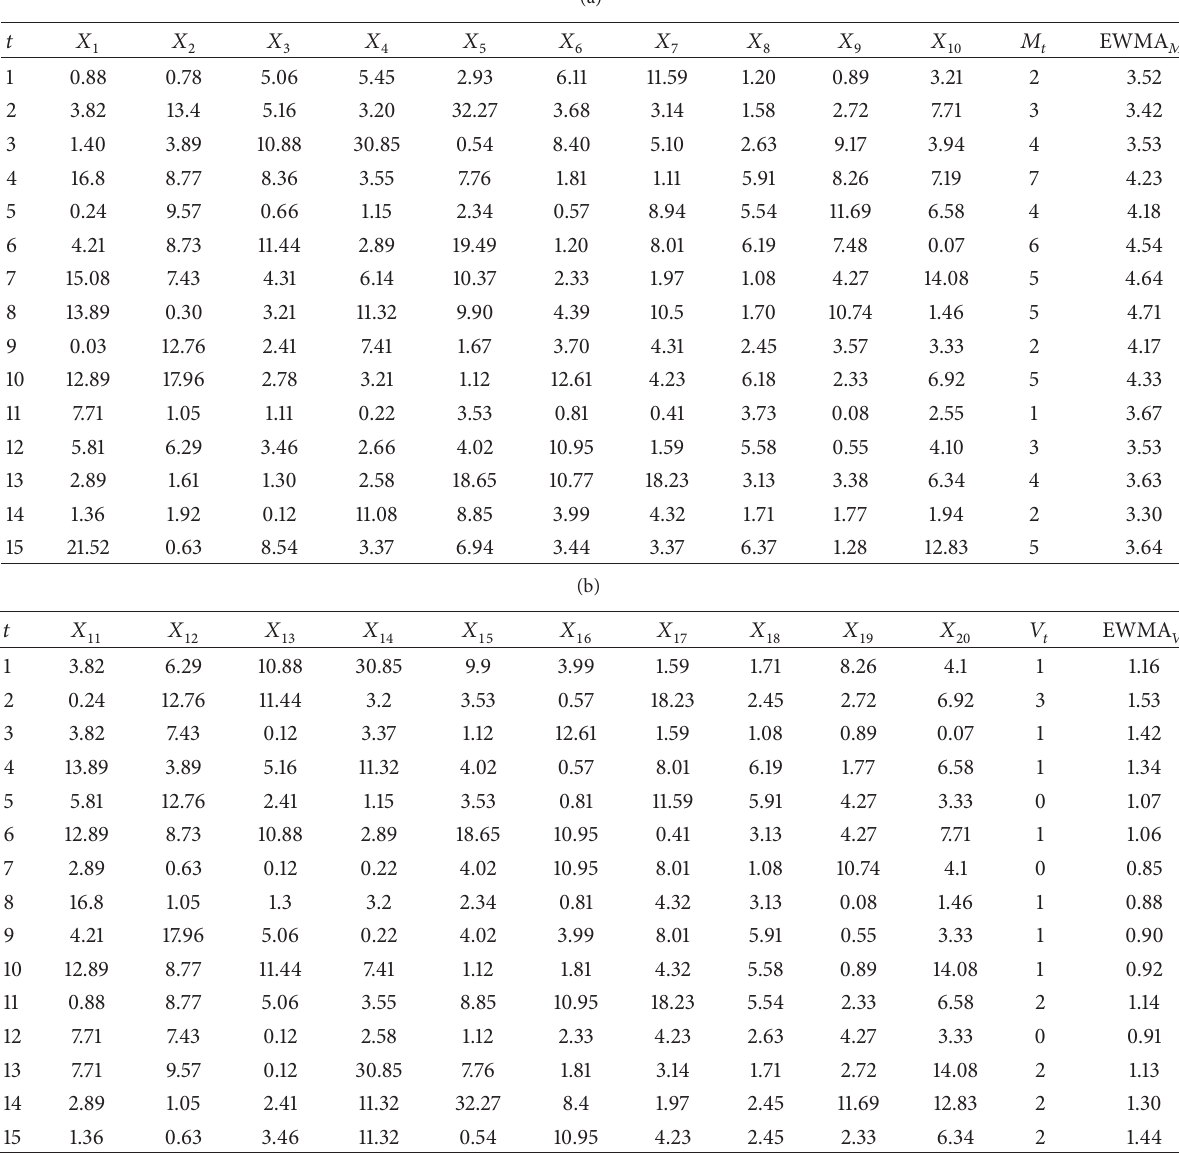
Table 14: (a) The service times from the first ten counters in a bank branch ( 𝜆 1 = 𝜆 2 = 0.2 ). (b) The service times from the last ten counters in a bank branch ( 𝜆 1 = 𝜆 2 = 0.2